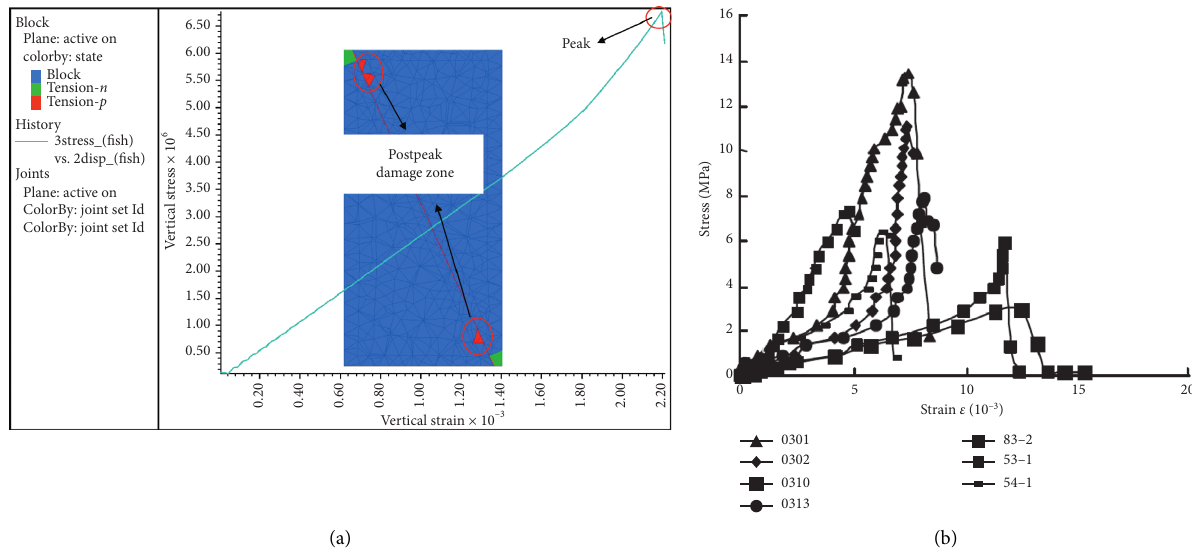
Figure 16: Comparison of test and simulated stress-strain curves. (a) RCA for 2%. (b) Parts of the rock sample and structural plane are broken [39].